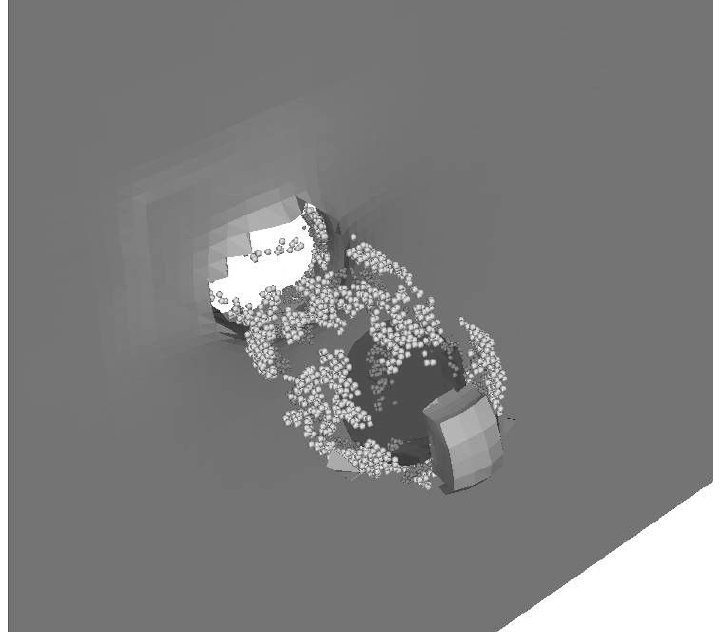
Fig. 5. FSP and particles with representative